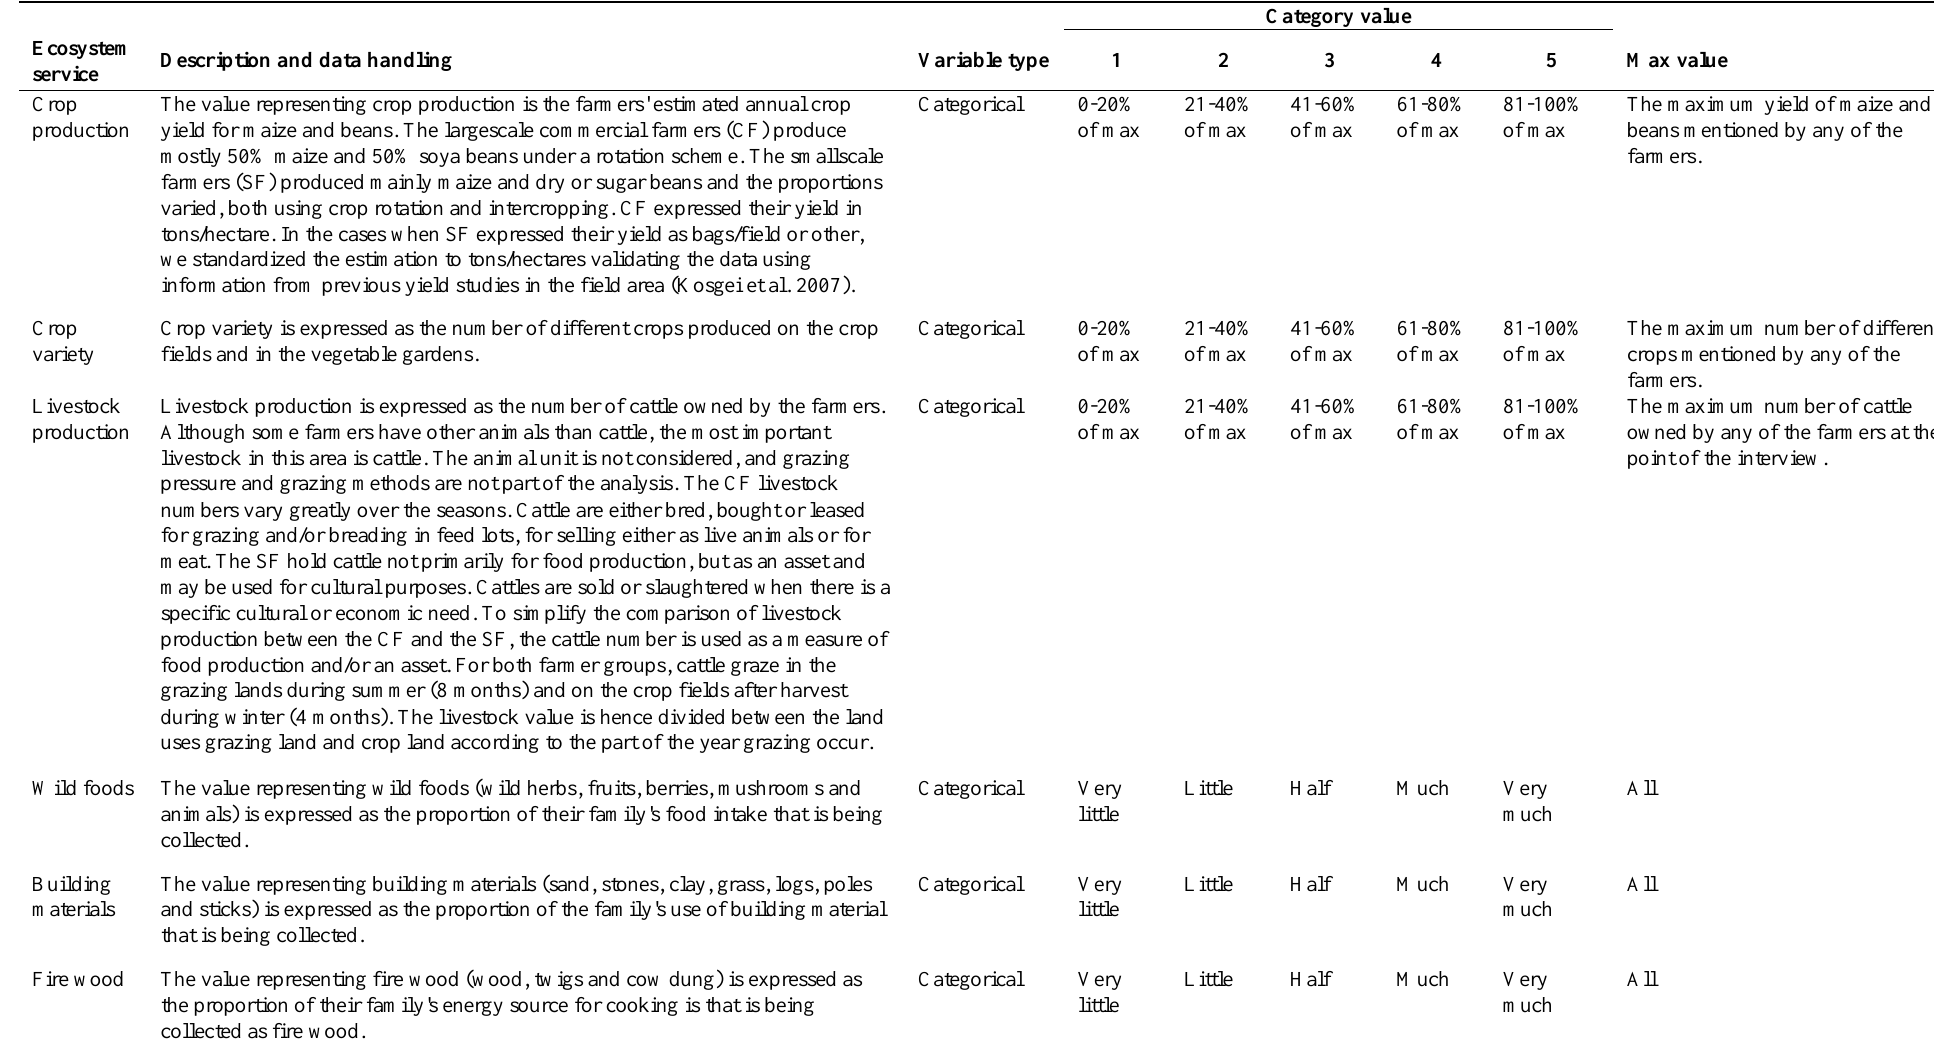
Table A1.1. Detailed summary of ecosystem services, description of variables and data handling, category values and max